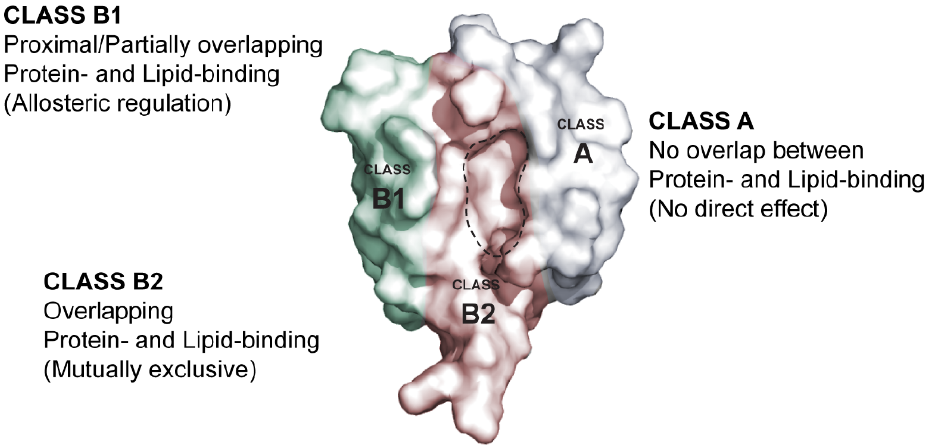
Figure 2. Proposed cationic patch classification of membrane lipid binding PDZ